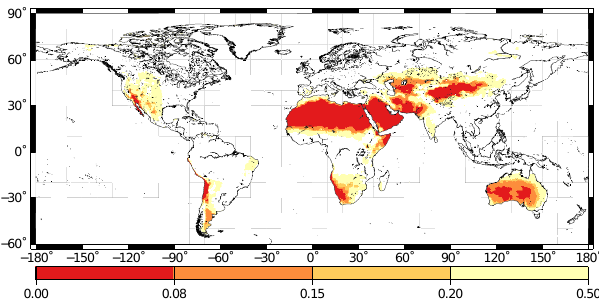
Figure 2. Simulated aridity index under the present climate (ratio of precipitation to potential evapotranspiration).